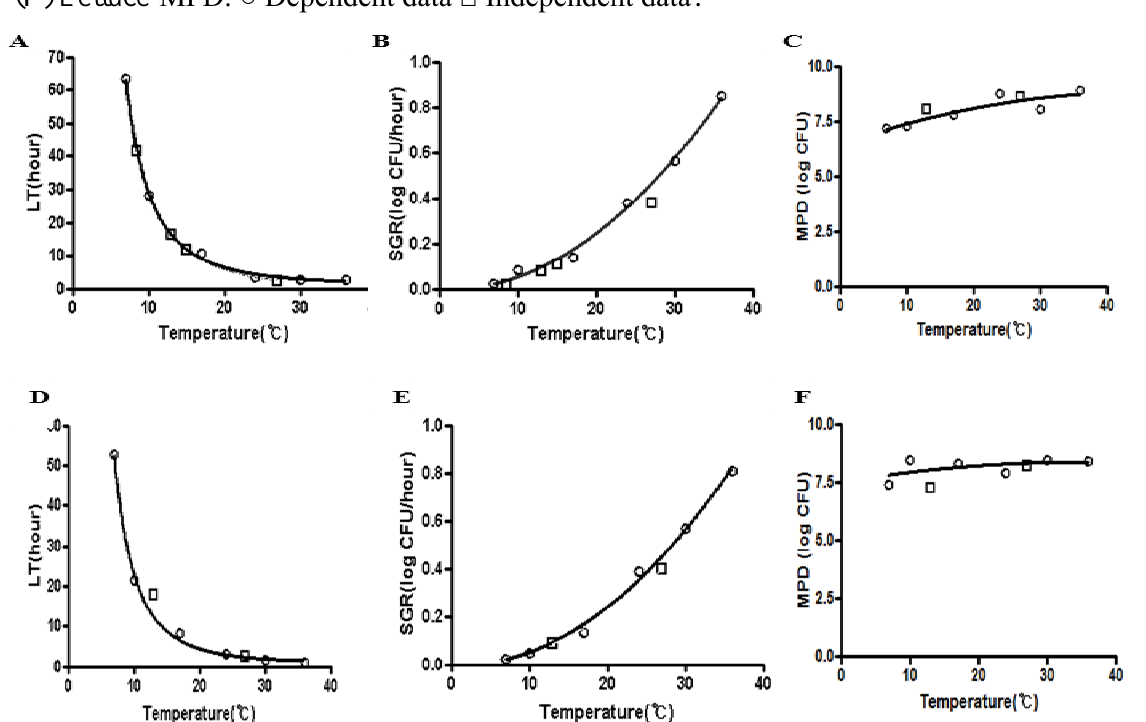
Figure 2. Secondary LT and SGR models of a mixture of E. coli O157:H7 NR in blanched spinach and fresh-cut iceberg lettuce as a function of temperature (7 to 36